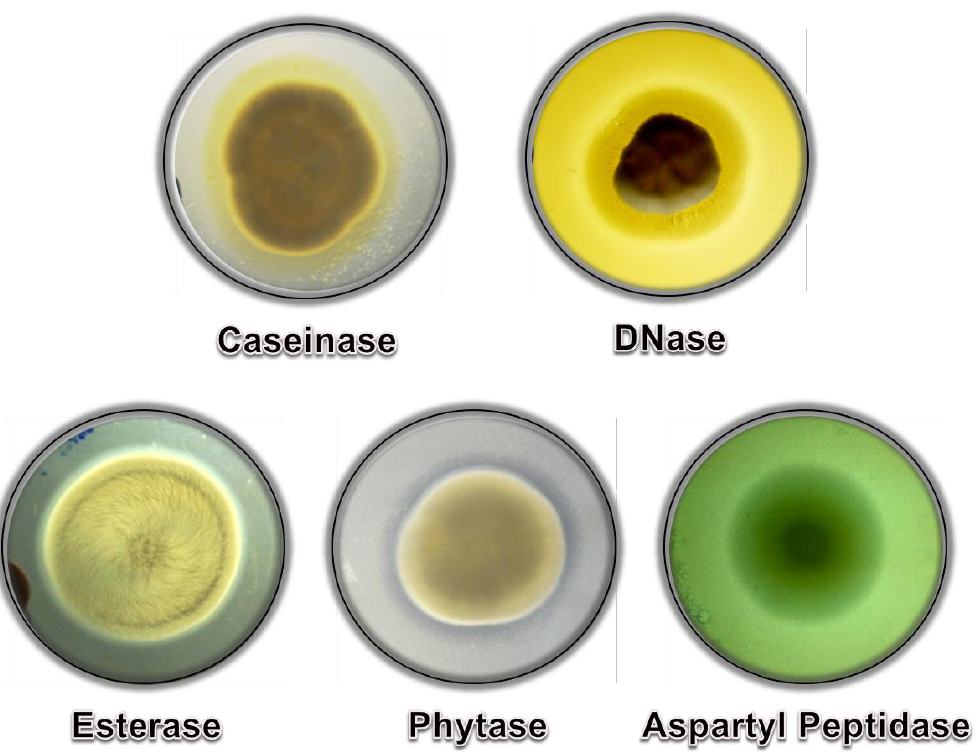
Figure 9. Examples of hydrolytic enzymes produced by S. apiospermum . The positive hydrolytic activity of caseinase, DNAse, esterase, phytase and aspartyl protease was determined through the detection of degradation halos around the fungal colony using distinct growth media containing specific substrates.